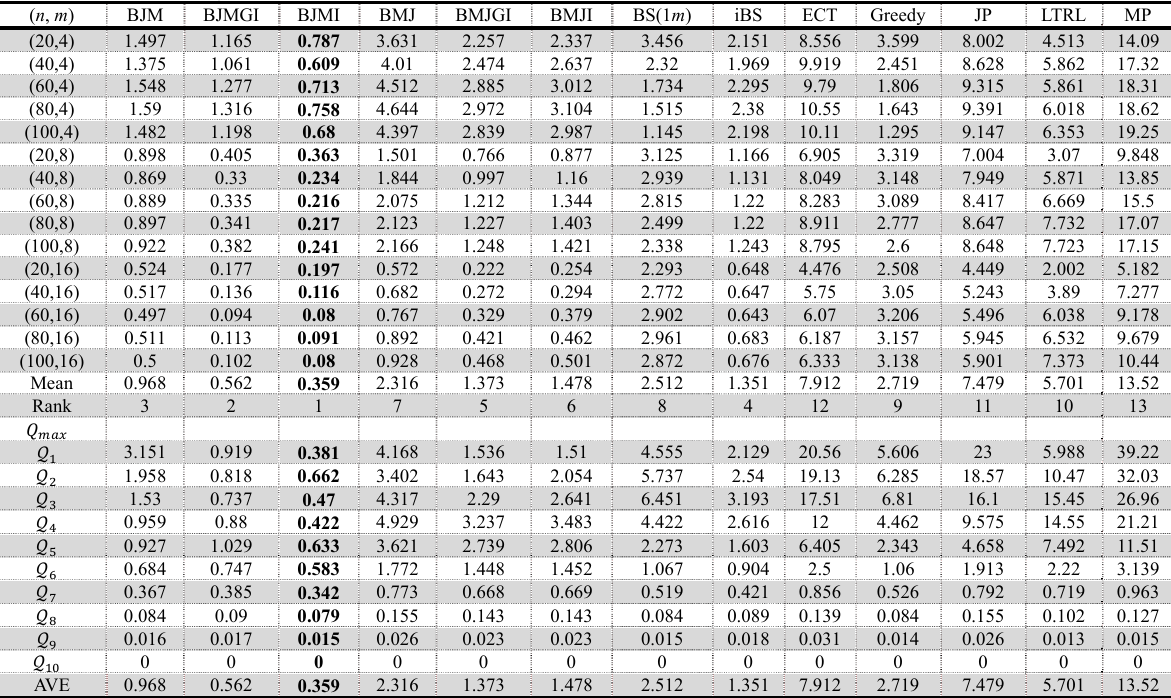
ARPI for heuristics(large